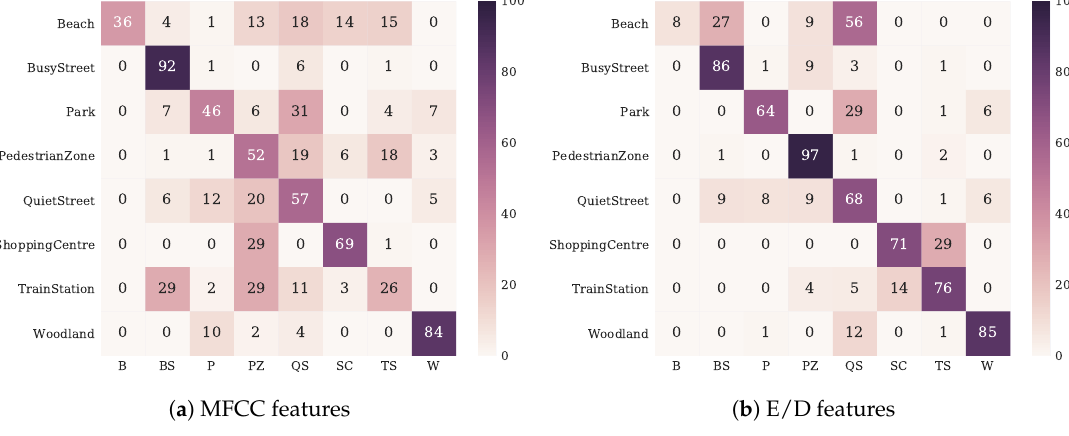
Figure 4. Confusion matrices of classifiers trained using MFCC features and elevation/diffuseness features extracted using DirAC. Figures indicate classification percentages across all folds (from